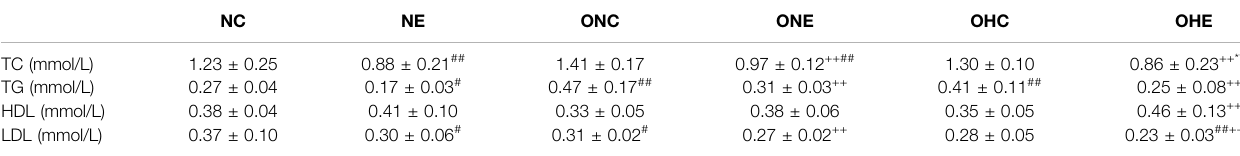
TABLE 3 | Changes in Blood Lipid levels in Rats after Normoxic and Hypoxic Exercise ( n = 8).